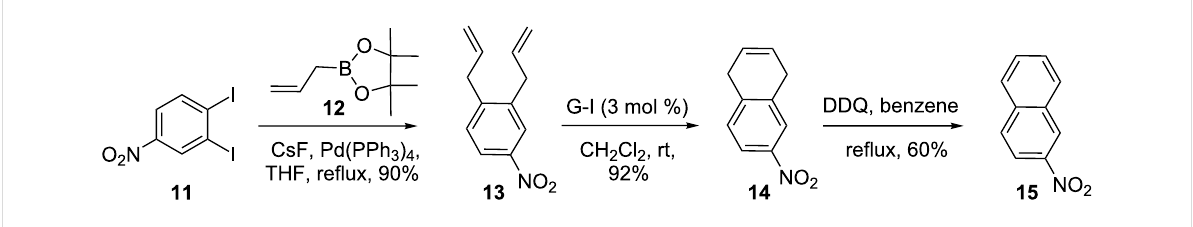
Scheme 2: Synthesis of polycycles via SM and RCM approach.